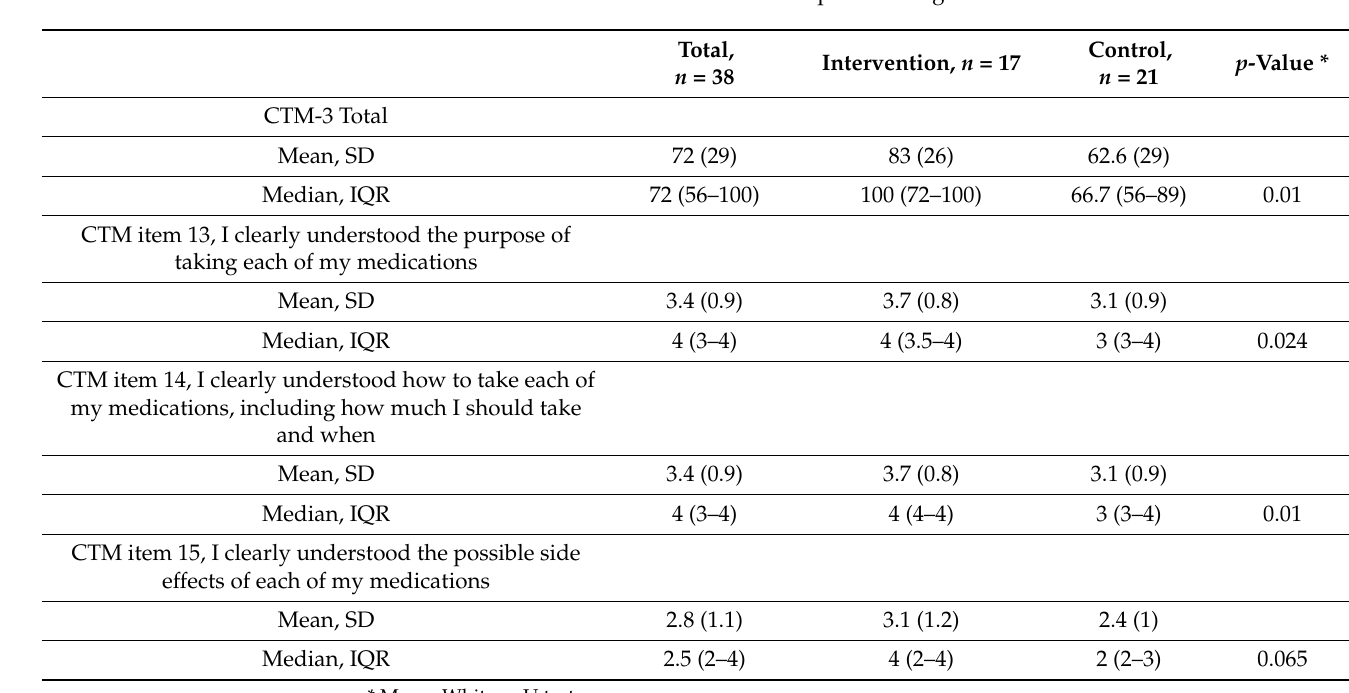
Table 2. Comparison between intervention group and control group for perceived understanding of information about medical treatment 1-week